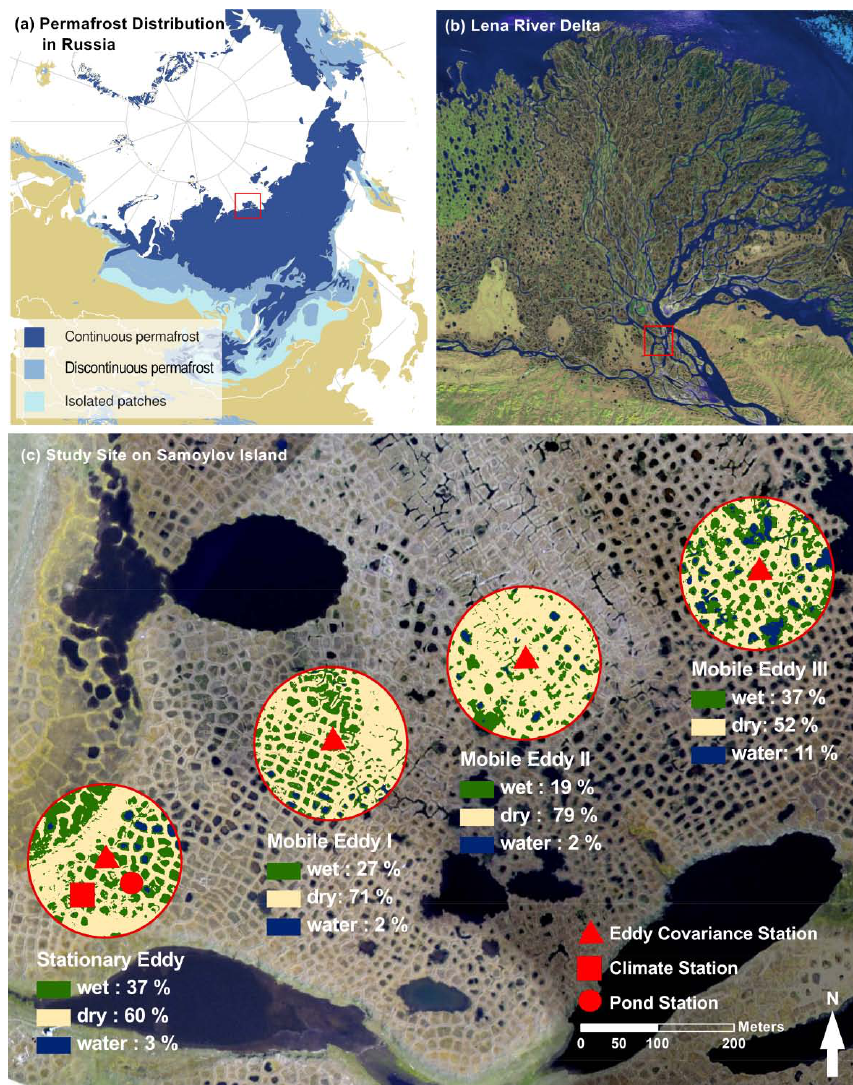
Fig. 1. (a) Permafrost distribution in Siberia (Brown et al., 1997); the location of the Lena River Delta is marked in red. (b) Satellite image of the Lena River Delta obtained from the Landsat Thematic Mapper (USGS, 2000); the location of Samoylov Island is marked in red. (c) High-resolution aerial image of the study site on Samoylov Island, where the considerable small-scale heterogeneity of the surface cover is visible. The locations of all installations are marked. The footprint areas of the eddy covariance systems are illustrated as circles with a radius similar to the average footprint extent. The fractions of wet, dry, and water surfaces in the relevant footprint areas are calculated using a footprint model of Schmid (1994) (see Sect.